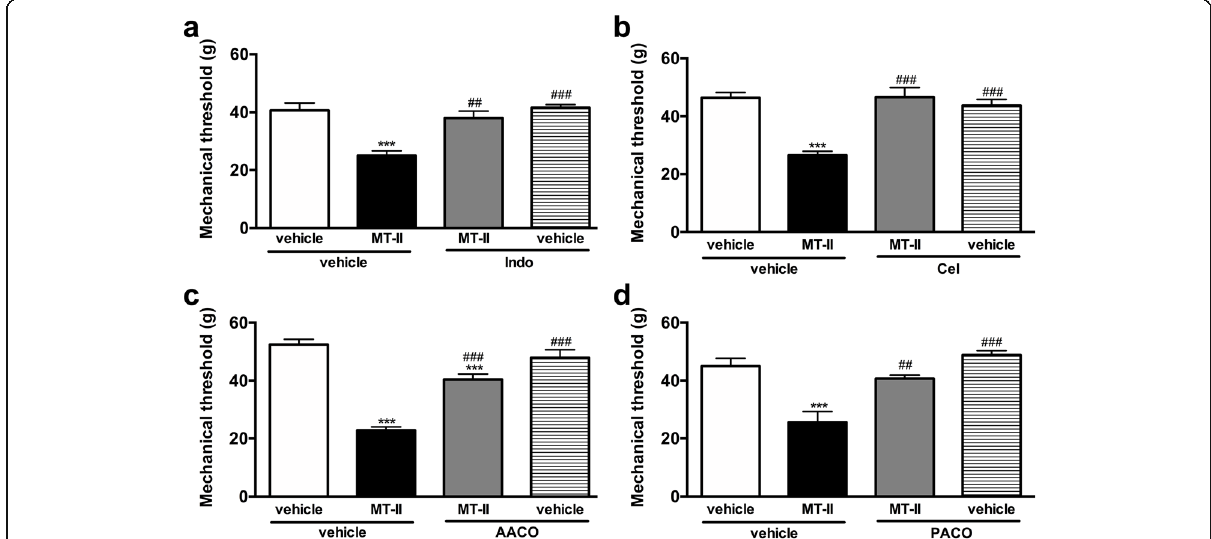
Fig. 4 Involvement of eicosanoids and endogenous phospholipases A 2 on MT-II- induced articular hyperalgesia. MT-II (10 μ g/joint) or PBS (vehicle) was injected in tibio-tarsal articulation (25 μ L). Pain threshold was determined using a modified electronic pressure-meter test 8 h after MT-II injection, and represented as force (in g ). a Indomethacin, a cyclooxygenase inhibitor (Indo, 4 mg/kg, 30 min before MT-II) or ( b ) celecoxib, a type-2 cyclooxygenase inhibitor (Cel, 10 mg/kg, 60 min before MT-II) or ( c ) arachidonyl trifluoromethil ketone, a selective inhibitor of cPLA 2 (AACO, 200 μ g/ joint, 30 min before MT-II) or ( d ) palmitoyl trifluoromethyl ketone, an inhibitor of iPLA 2 (PACO, 1 μ g/joint, 30 min before MT-II) was injected prior to MT-II. Each point represents the mean±SEM of six animals. *** p <0.001 indicate statistically significant differences when compared with control group (vehicle+vehicle). ## p <0.01 and ### p <0.001 indicate statistically significant differences when compared with MT-II group